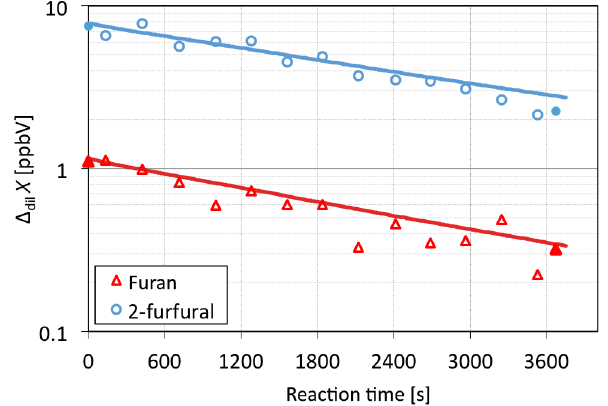
Figure 9. Dilution-corrected molar excess mixing ratios of formaldehyde (a) , acetaldehyde (b) , methanol (c) , and ace- tone/propanal (d) during 1h of plume evolution. Point symbols refer to the measured data (1km bins); solid lines represent the output of the UWCM fed with MCM v3.3 chemistry.